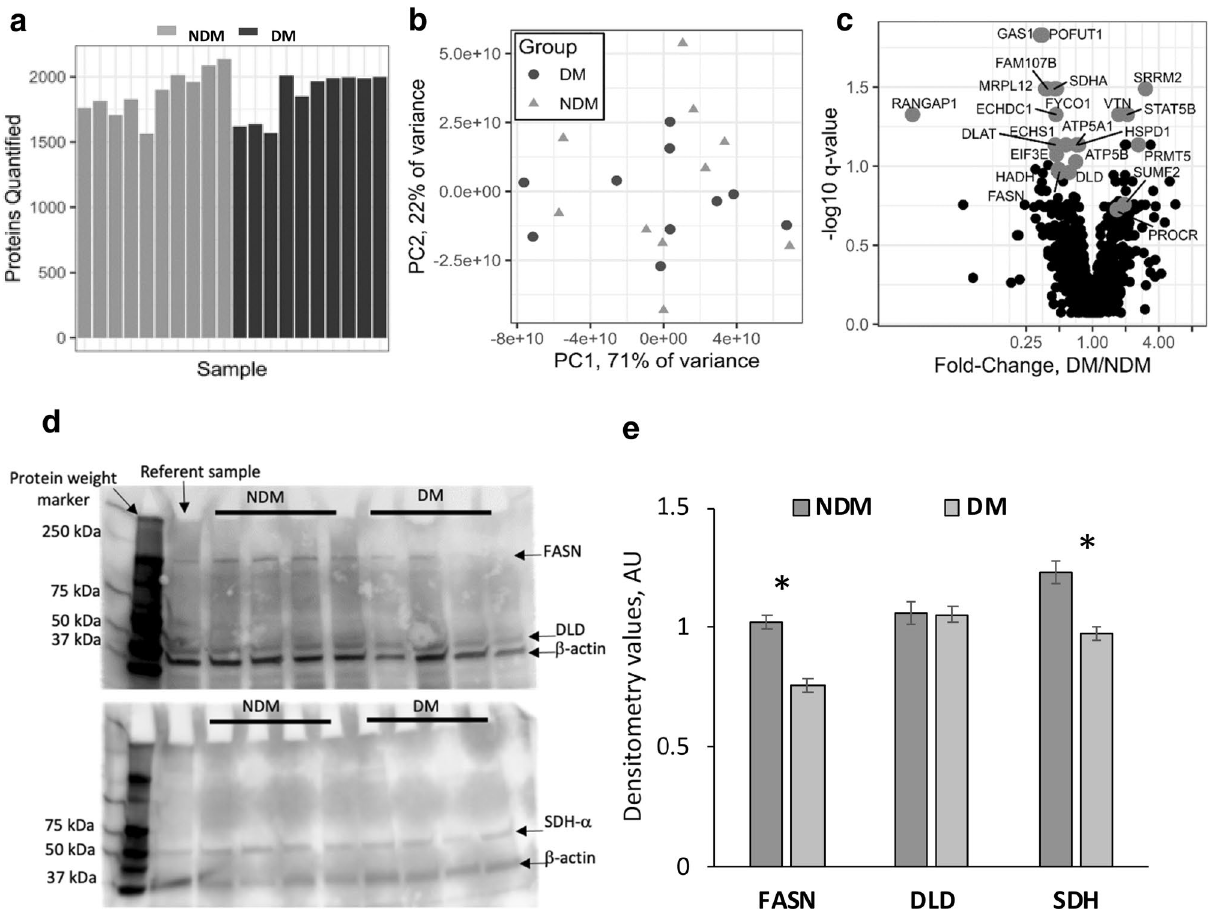
Figure 1. Sample preparation and differentially abundant proteins in DM and NDM tissues. Sample preparation was reproducible and similar between groups, as determined by the number of proteins quantified ( a ) and principal component analysis ( b ); no significant difference between groups was observed in number of proteins quantified; principal component projection does not separate DM from NDM samples indicating that overall protein composition of samples is similar between groups. ( c ) Volcano plots of protein abundance in DM compared with NDM samples. Light grey dots indicate differentially abundant proteins between groups; black dots represent proteins that were not significantly regulated. Labels indicate gene symbols. ( d ) Western blots for select targets differentially regulated in proteomic analysis. ( e ) Western blotting densitometry quantification. *p-value < 0.001, independent t-test comparing NDM (n = 8) to DM (n = 8) densitometry values, normalized to actin as described in